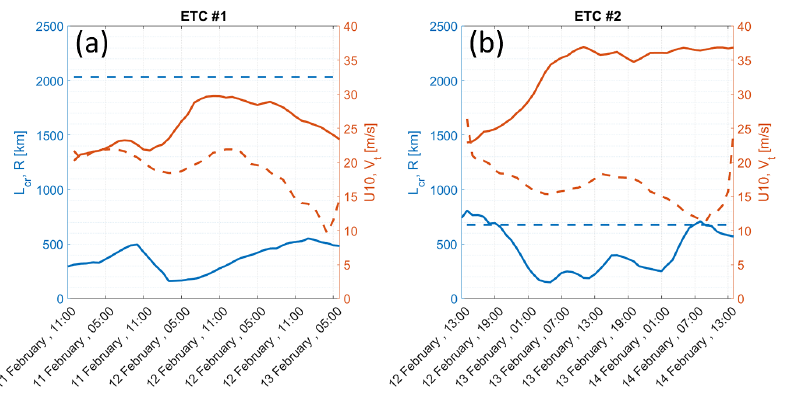
Figure 2. Time evolution of ETC#1 ( a ) and ETC#2 ( b ) parameters: (red thick line) maximum wind speed, u m ; (red dashed line) translation velocity, V t ; (blue thick line) radius of maximum wind speed, R m ; (blue dashed line) critical fetch, L cr from